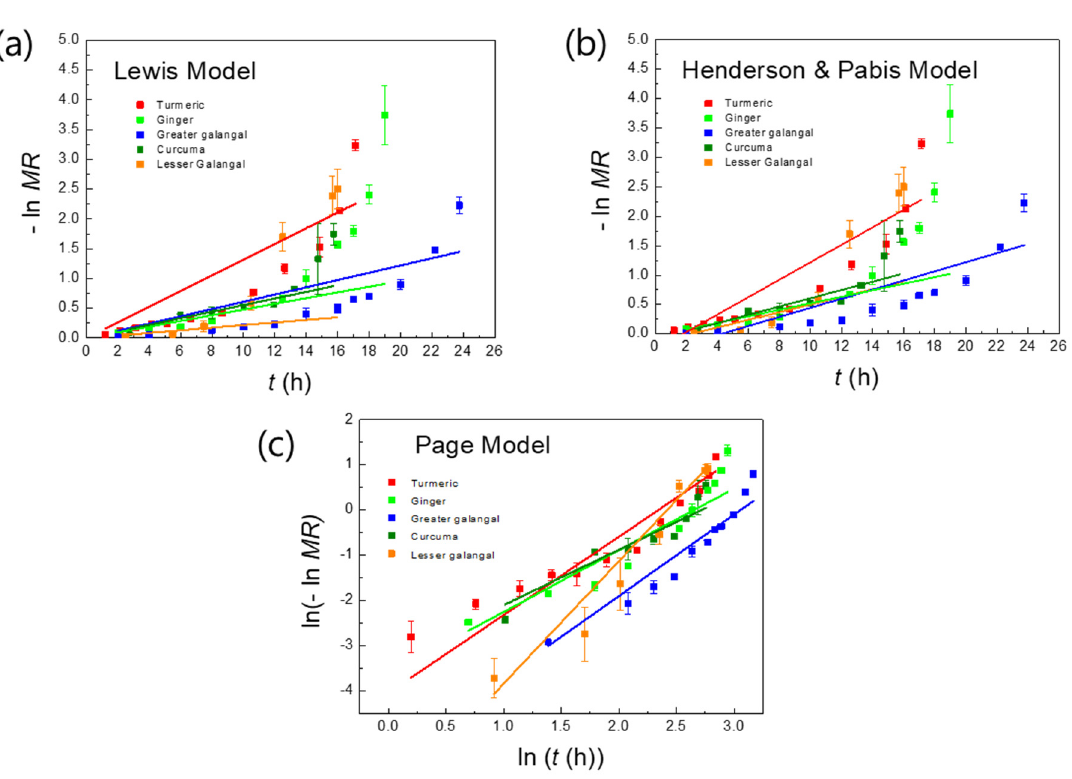
Figure 7. Drying data of medicinal plant materials in the Polydryer with heater operation fitted using linear logarithmic equations of ( a ) Lewis model, ( b ) Henderson and Pabis model, and ( c ) Page model.